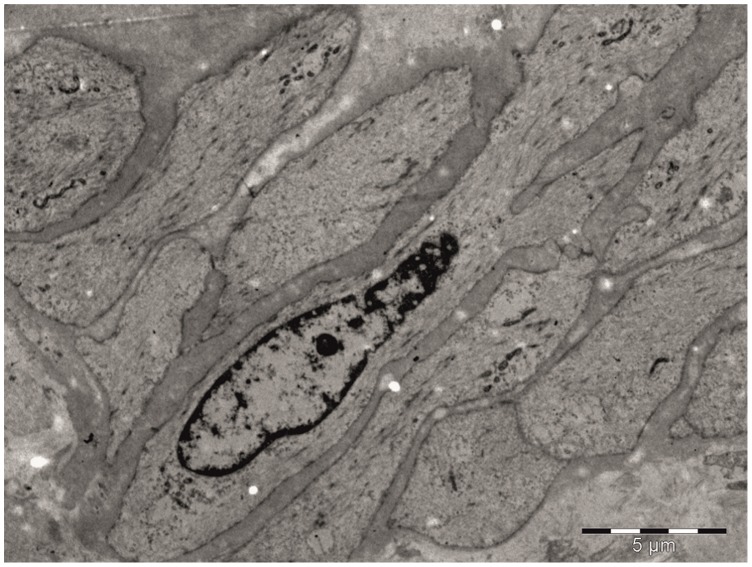
TEM analysis of a graft from an SVGD (−) patient.Electron micrograph showing the tunica media of the saphenous vein obtained from an SVGD (−) patient. Smooth muscle cells with typical organization for this layer were observed. Note, that the cytoplasm is poorly equipped with organelles. Only a small number of mitochondria were observed.